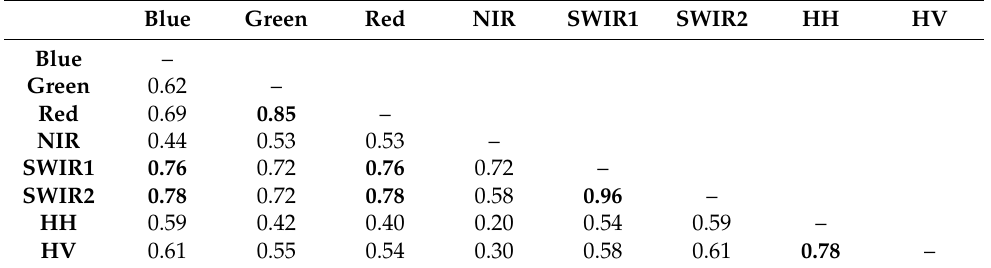
Table 3. Relationship between parameters, the R 2 higher than 0.75 were displayed in bold font. Blue